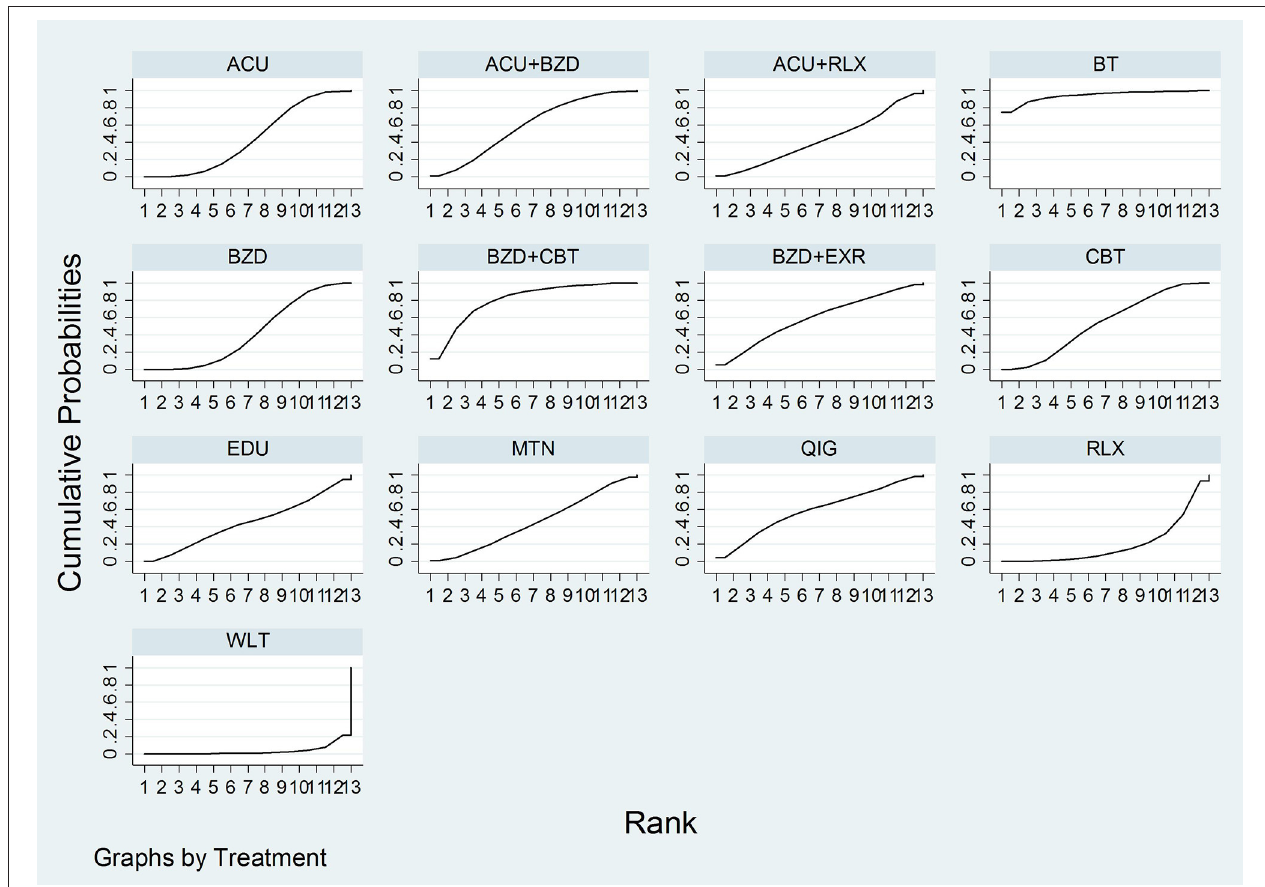
FIGURE 3 | SUCRA for PSQI total score. ACU, acupuncture; BT, behavioral treatment; BZD, benzodiazepines; CBT, cognitive behavioral therapy; EDU, sleep education; EXR, exercise; MTN, melatonin; QIG, qigong; RLX,